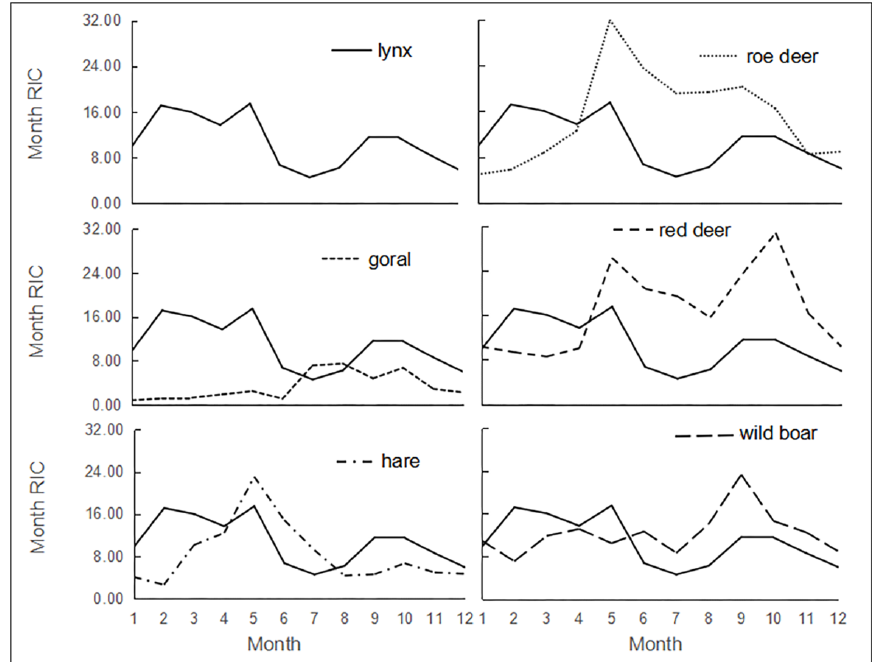
Figure 3. The monthly activity pattern of lynx and its main prey in Saihanwula.